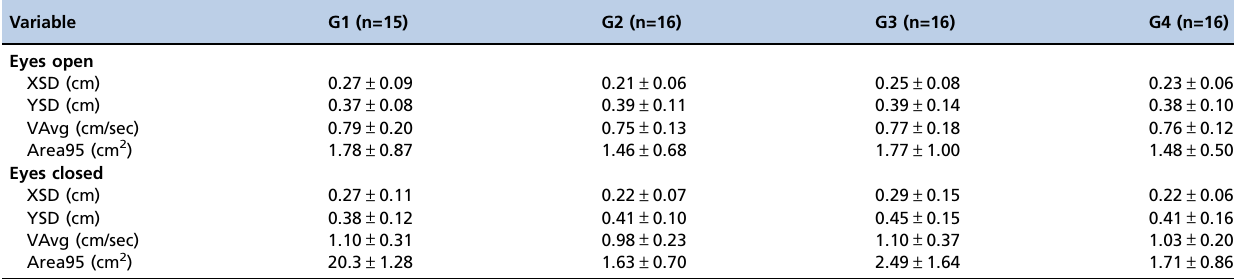
Table 4 - Balance performance of the study participants in each group (G).